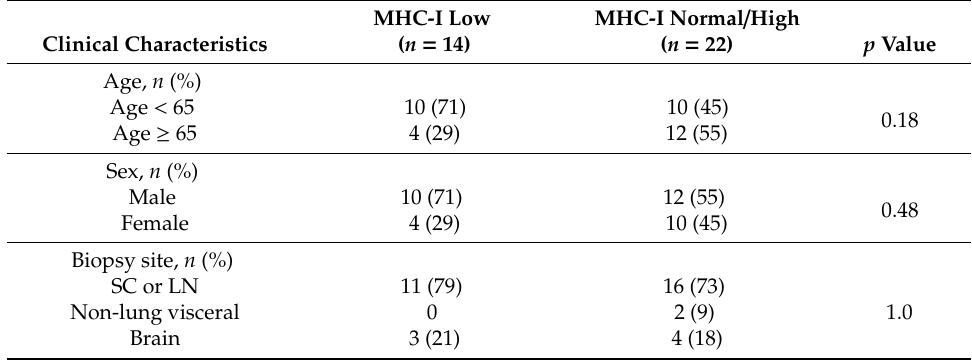
Table 2. Baseline clinicopathologic characteristics according to tumor MHC-I